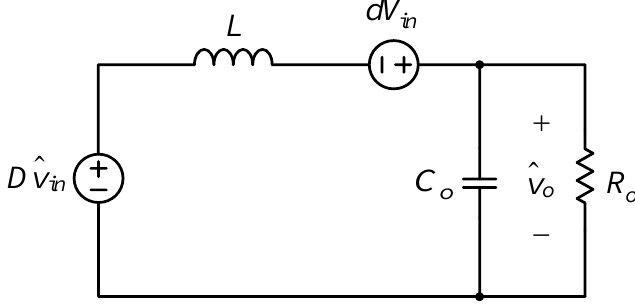
Figure 11. Small-signal AC model of the proposed inverter.